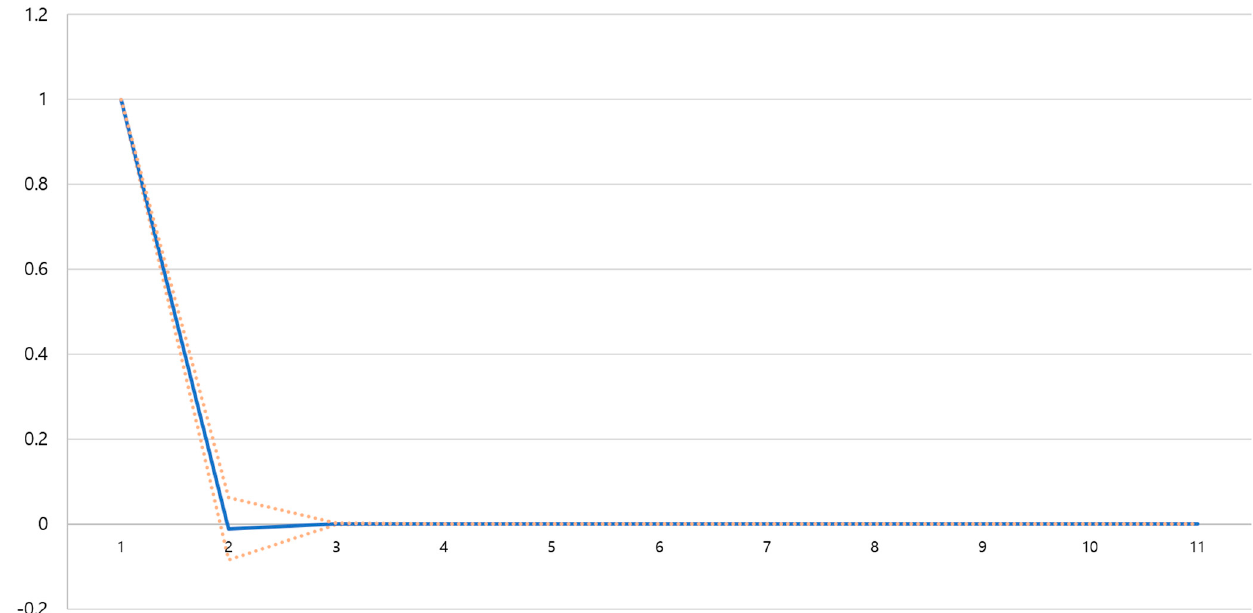
Figure 4. Estimation of the impact response period of retail chicken prices according to the Avian Influenza (AI)-related news frequency. The x axis indicates period (day) and the y axis indicates retail price responded to impulse. Table 8. Comparison of the Prediction Accuracy of the Threshold Autoregressive (TAR) and Autore- gressive (AR)